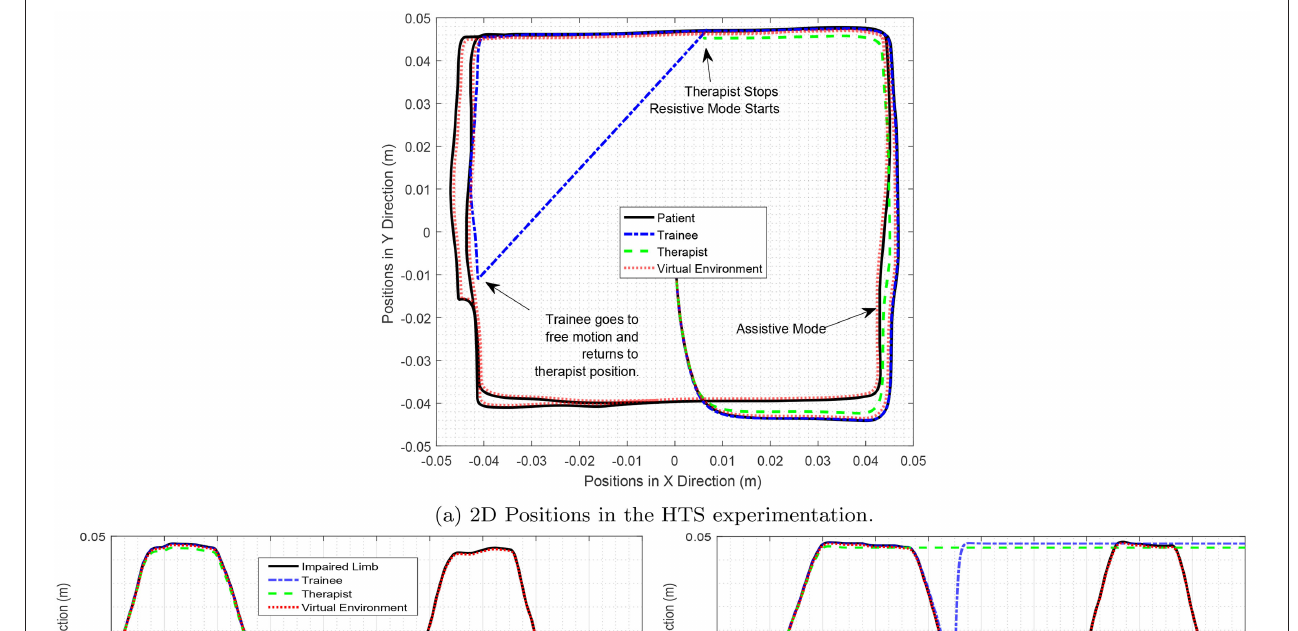
So, the concept of unilateral teleoperation is changed to multi- lateral teleoperation, because the desired force forms a closed- loop structure. The varying delays in the channels are considered as (45), and remaining delays in the channels are selected as